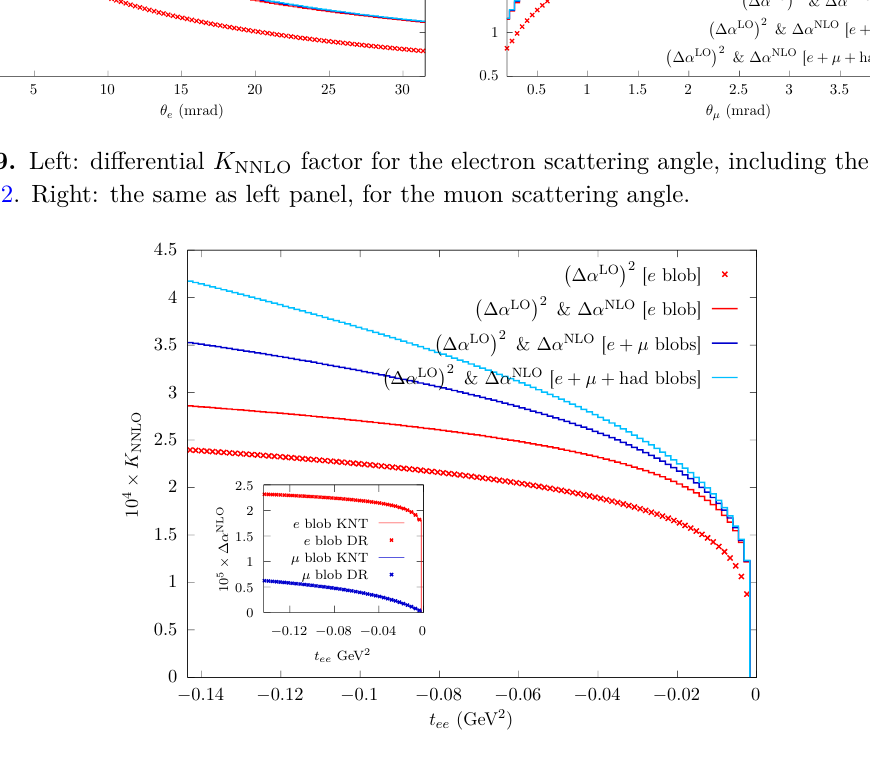
Figure 10. Effects of the diagrams of figure 2 on the t ee